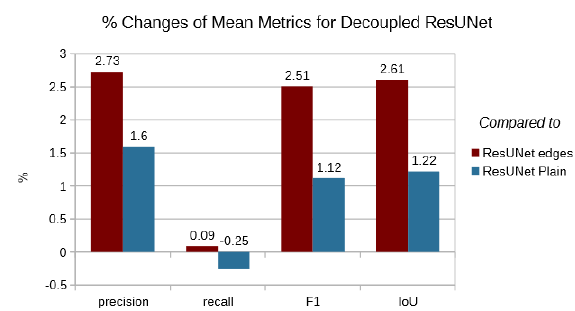
Figure 9. Comparison of average evaluation metrics between the proposed architecture and the baseline models.